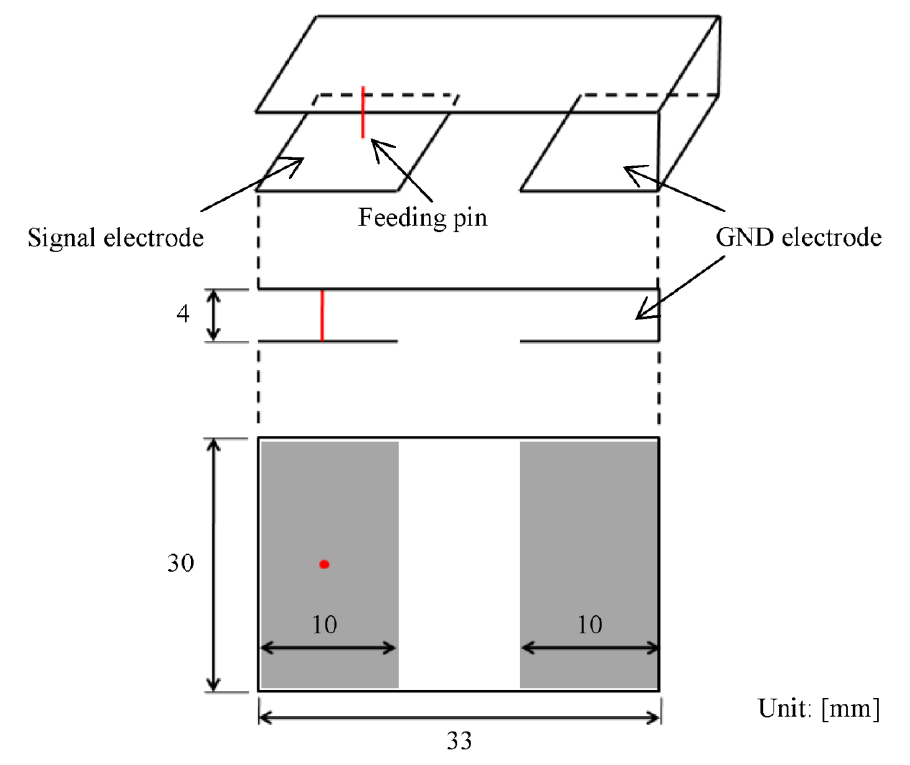
Figure 4. Structure of the proposed dual-mode antenna.